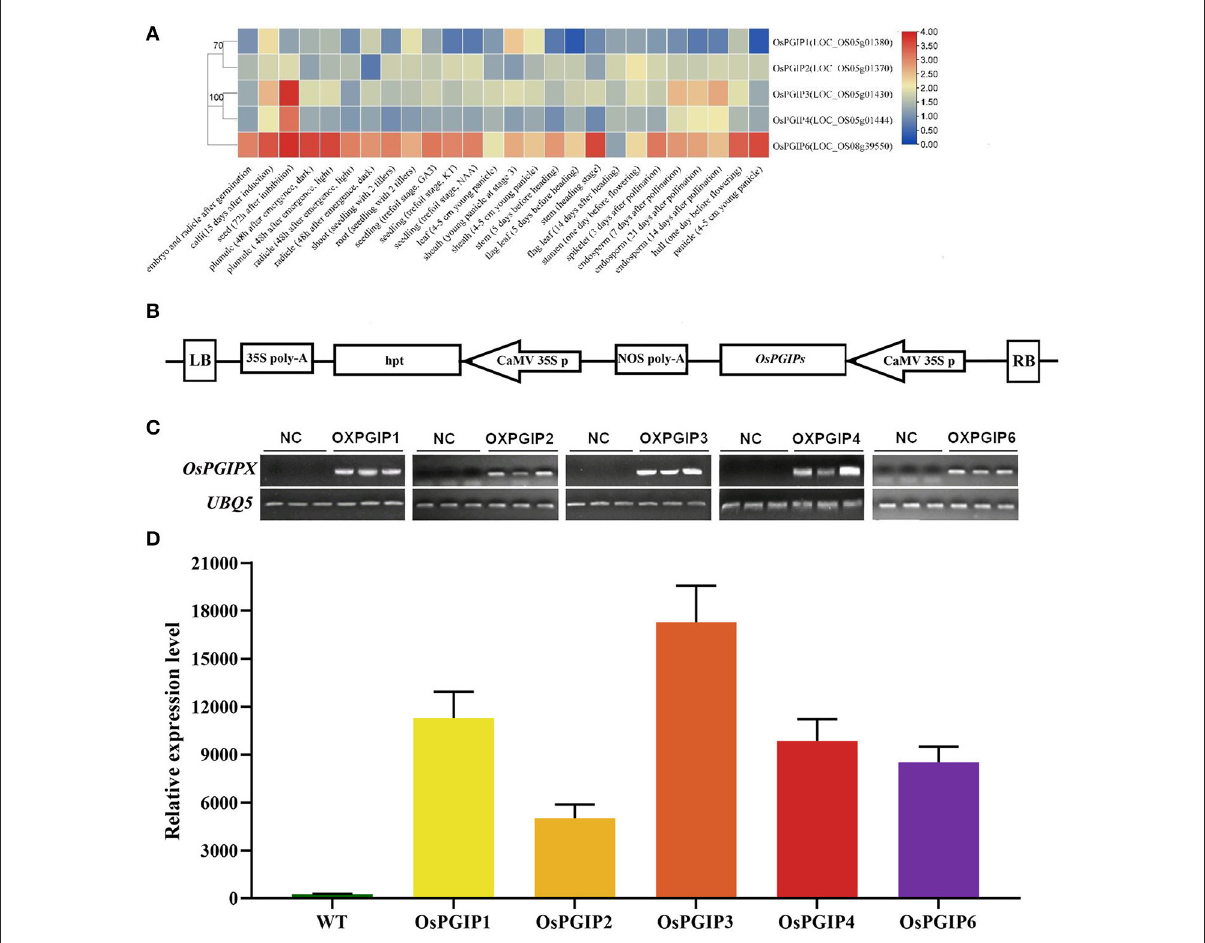
FIGURE2 The expression analysis of OsPGIPs in rice and transgenic Arabidopsis plants. (A) The expression of OsPGIPs in various tissues and organs throughout the entire life cycle of rice. The color scale (representing |lg signal values|) is shown on the right. (B) Schemes of recombinant plasmids for overexpression. The expression level of each target gene was analyzed by RT-PCR (C) and qRT-PCR (D) with three independent transgenic lines. NC, negative control, Error bars indicate SE based on three independent biological replicates.